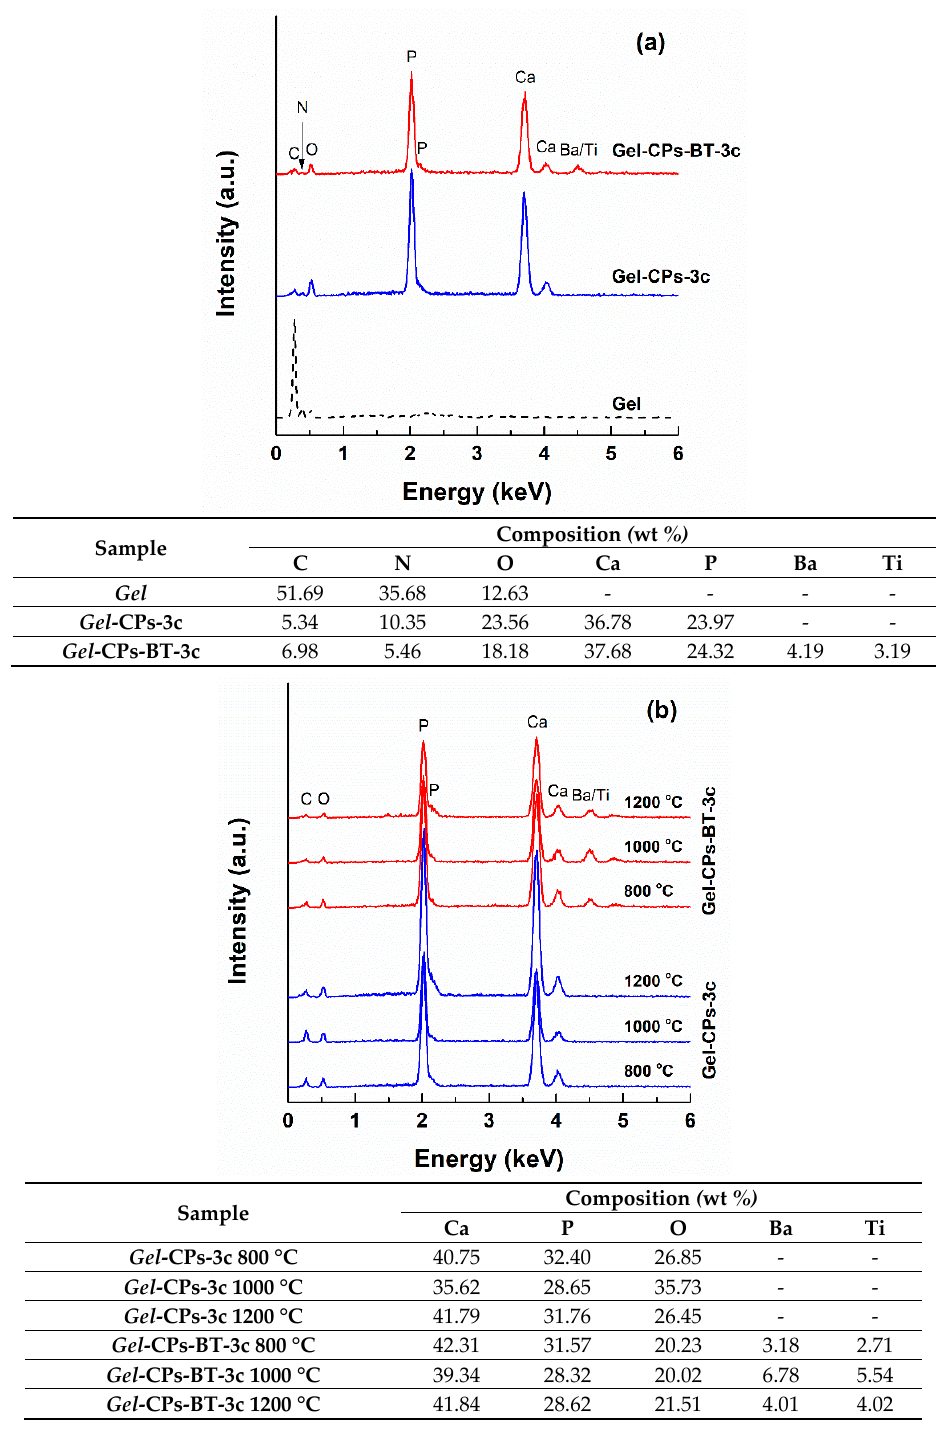
Figure 7. Energy-dispersive X-ray spectroscopy (EDX) spectra and corresponding elemental compositions of the obtained materials: ( a ) before the thermal treatments and ( b ) after the thermal treatments.